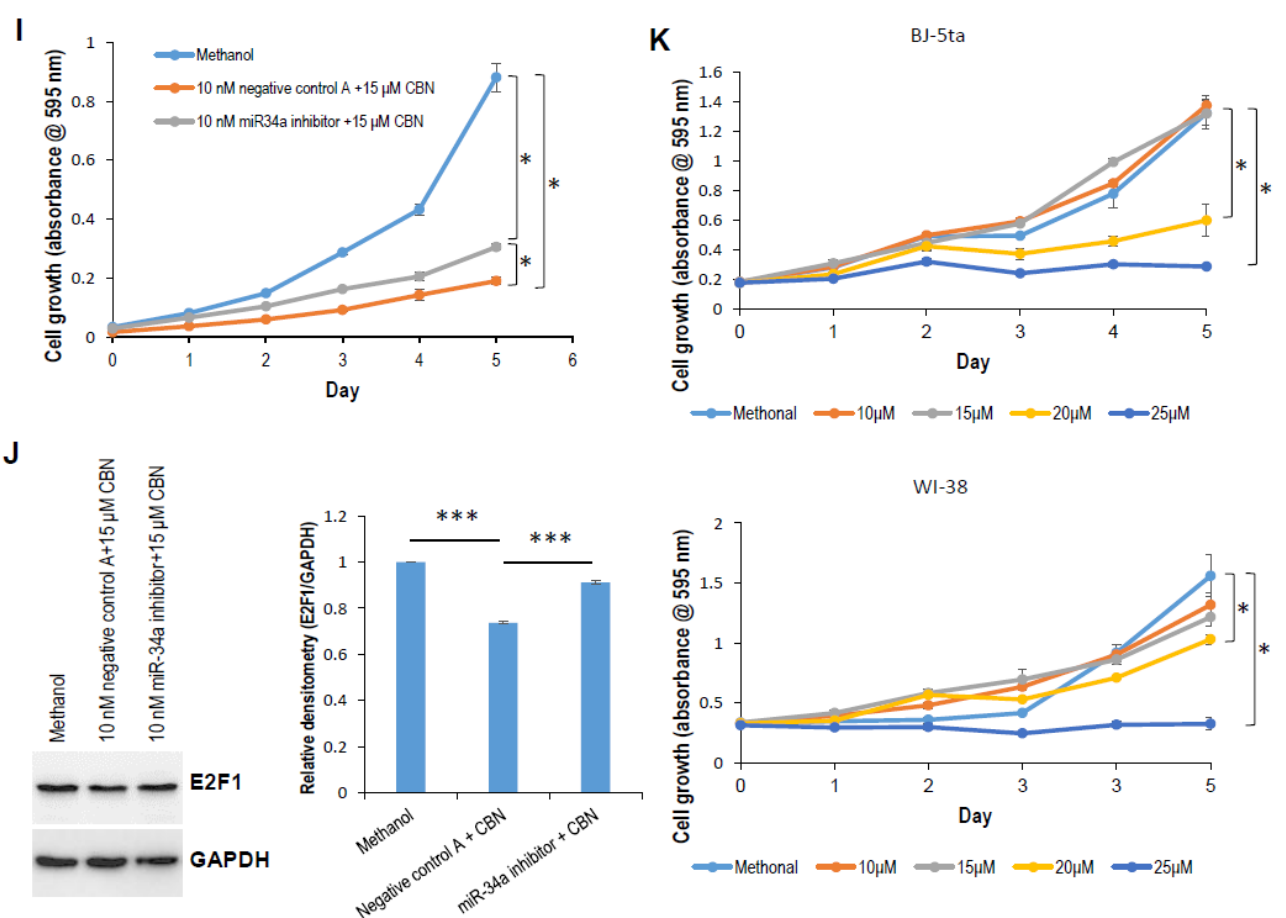
Figure 2. Anti-neuroblastoma effect of CBN via inhibition of AKT pathway and transactivation of miR-34a. ( A ) 1000 IMR-5 cells per well and 2000 SK-N-AS cells per well were plated in 96-well plates. At 24 h after plating, cells were treated with the indicated concentration of CBN, and MTT assay was performed using Cell Proliferation Kit I as described in Section 4. ( B , C ) IMR-5 and SK-N-AS cells grown to 85% confluency were exposed to either 15 or 20 μM CBN. At 48 h after treatment, cells were harvested for cell cycle and apoptosis analyses. ( D ) Tube formation assay was carried with 50% of conditioned medium from either IMR-5 or SK-N-AS cells exposed to either 15 or 20 µM CBN as detailed in Section 4; representative images were taken using a fluorescence microscope (100×). Data were expressed as mean ± SD for five images. ( E ) Cell invasion assay was performed using 33% of conditioned medium from either IMR-5 or SK-N-AS cells exposed to either 15 or 20 µM CBN as detailed in Section 4; representative images were taken under inverted microscope (200×). Data were expressed as mean ± SD for five images. ( F ) IMR-5 and SK-N-AS cells grown to 85% confluency were exposed to either 15 or 20 μM CBN. At 48 h after treatment, total RNA was isolated and subjected to qRT-PCR analysis using hsa-miR-34a primer set. ( G , H ) IMR-5 and SK-N-AS cells grown to 85% confluency were exposed to either 15 or 20 μM CBN. At 48 h after treatment, whole cellular lysates were prepared and subjected to Western blotting with antibodies to CBR2, pAKT1/2/3, AKT1, pERK1/2, ERK1/2, CDK2, cyclin E1, E2F1, notch1, snail, and p53, GAPDH served as a loading control. ( I ) IMR-5 cells grown to 80% confluency were transfected with either 10 nM LNA miR-34a Power Inhibitor or 10 nM negative control A. At 24 h after transfection, 2000 cells per well were plated in 96-well plates and exposed to 15 μ M CBN; MTT assay was carried out as described in Section 4. ( J ) IMR-5 cells grown to 80% confluency were transfected with either 10 nM LNA miR-34a Power Inhibitor or 10 nM negative control A. At 24 h after transfection, cells were exposed to 15 µM CBN. At 48 h after exposure, whole cellular lysates were prepared and subjected to Western blotting with antibody against E2F1; GAPDH served as a loading control. ( K ) 3000 BJ-5ta cells per well and 5000 WI-38 cells per well were plated in 96-well plates. At 24 h after plating, cells were exposed to the indicated concentration of CBN, and the MTT assay was performed using